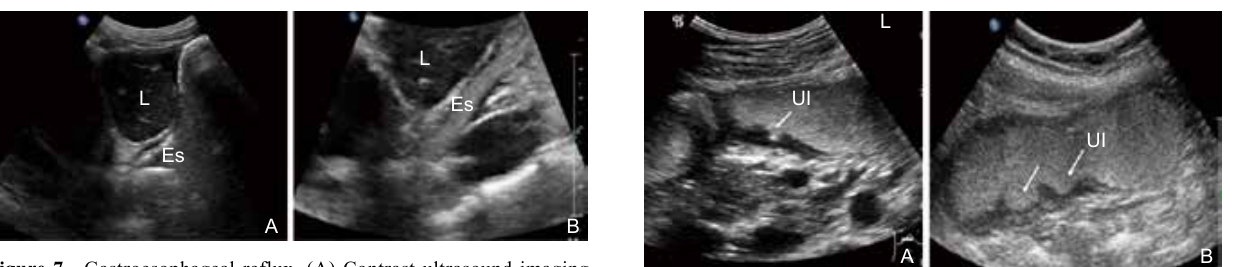
Figure 10 Gastric ulcer. (A) contrast ultrasound imaging shown superficial gastric ulcer (arrow); (B) Contrast ultrasound imaging identified deep gastric ulcers (arrows). Ul, ulcers.